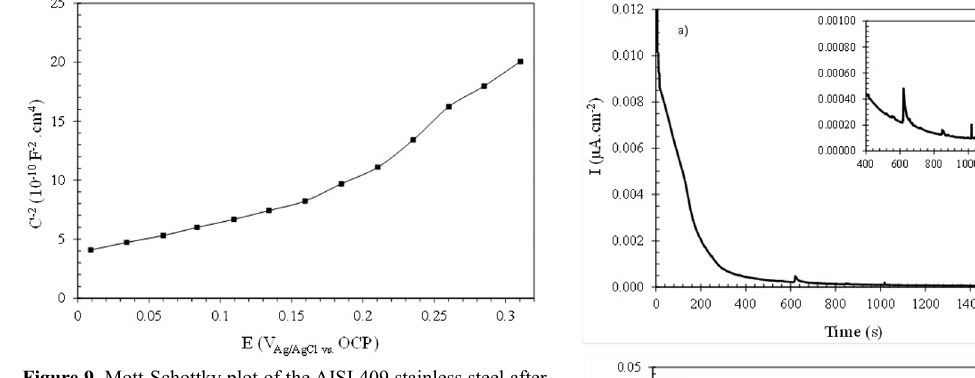
of the Mott-Schottky plot, according to equation (5). The